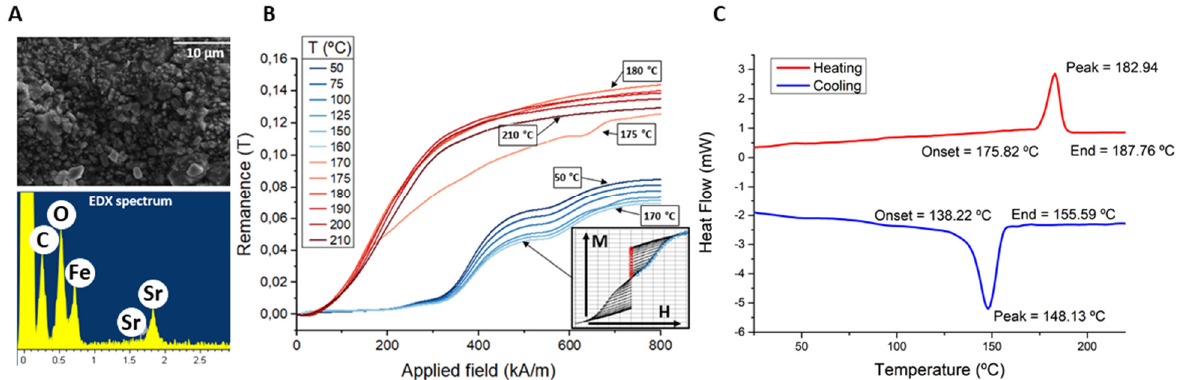
Figure 3. Characterization of the MPC1 used in the experiments: ( A ) SEM image of the surface of the polymer that shows the size of the magnetic particles and EDX analysis that shows the composition of the filler (SrFe); ( B ) remanence magnetization vs. applied field curve measured at different temperatures (inset: minor loops from where remanence was extracted); ( C ) DSC thermogram of the MPC.